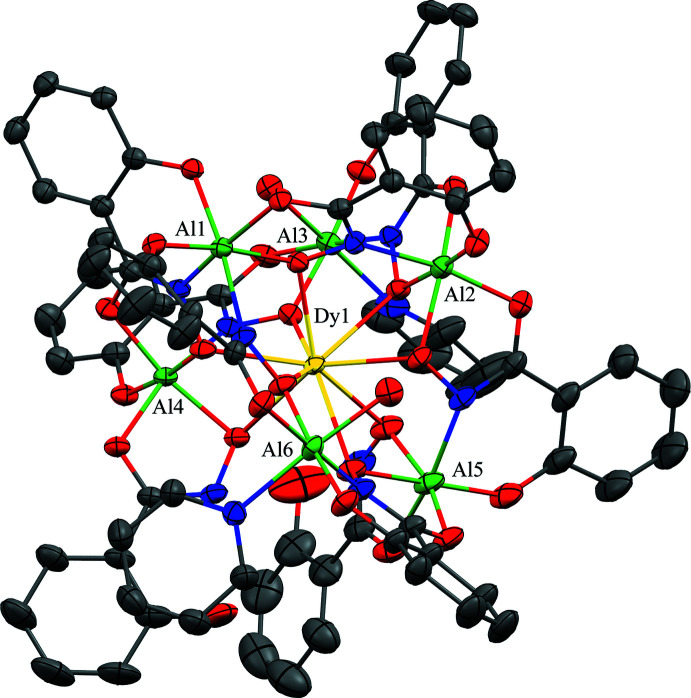
The single-crystal X-ray structure of [Hpy]2[DyAl6(H2shi)2(shi)7(py)1.855(H2O)2]·7.429py·H2O, 2, with displacement ellipsoids at the 50% probability level. See Fig. 1 ▸ for additional display details.